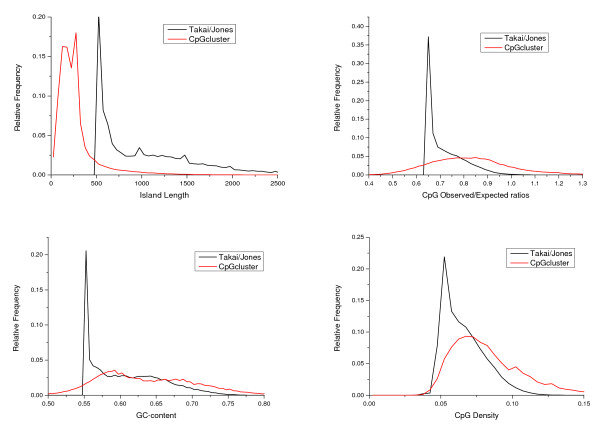
Comparison of the distributions of the island length for both the CpGcluster and Takai/Jones algorithm (top left); the observed to expected ratios of CpG frequencies (top right); the island GC-content (bottom left); and the island CpG density (bottom right). It can be seen that, for all this four properties, the SWA distributions are heavily biased towards their respective thresholds. However, CpGcluster distributions do not show this artifact.